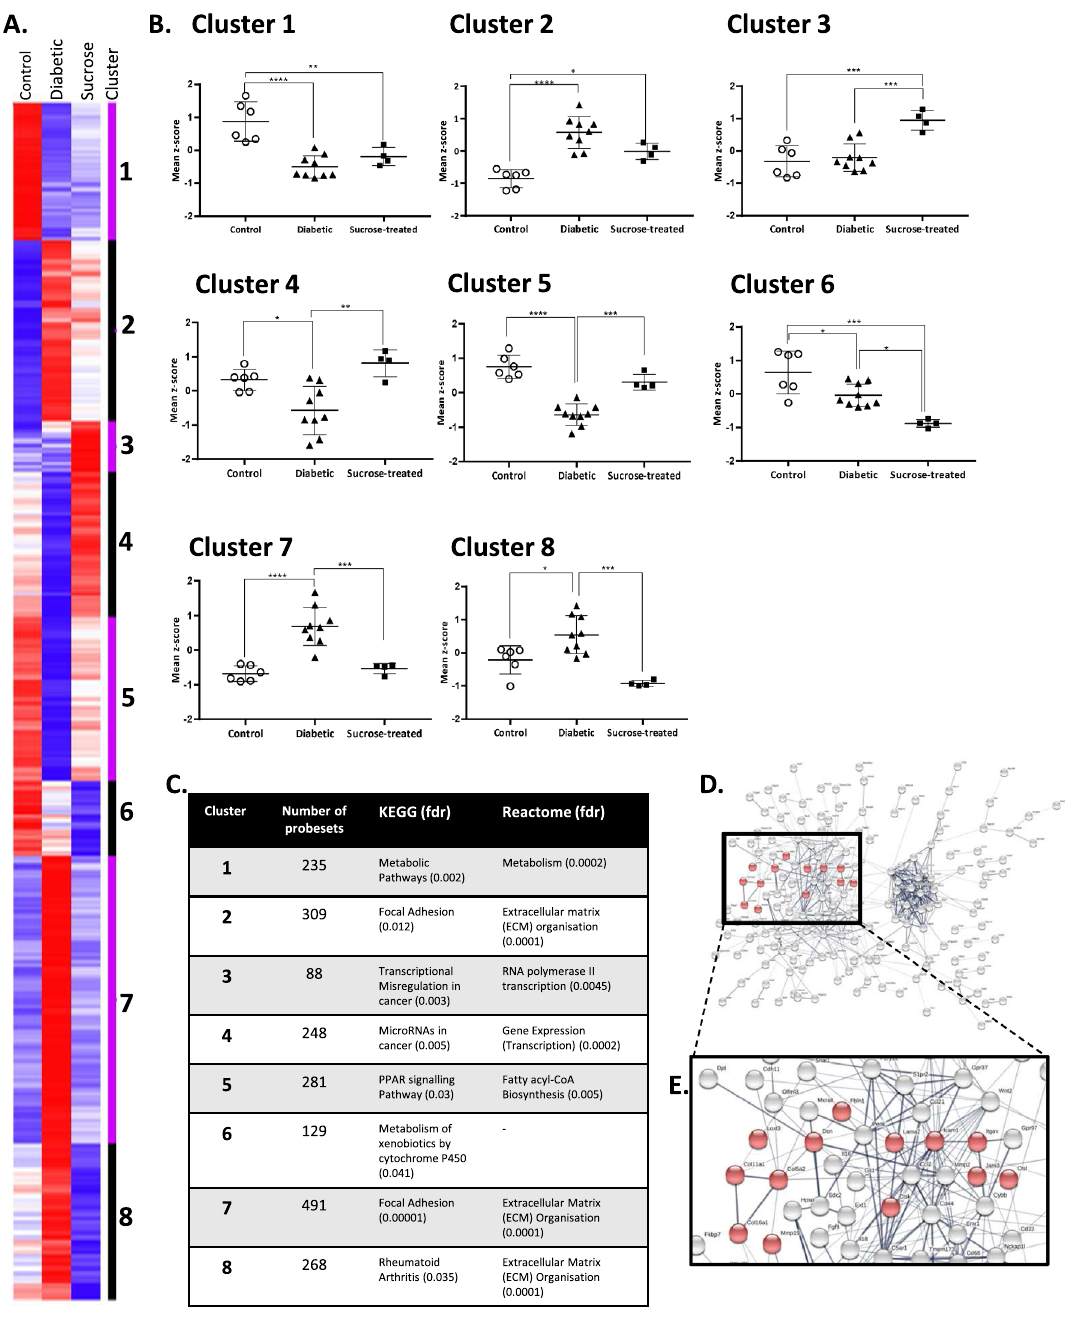
Figure 4. Cluster analysis demonstrates an altered pattern of transcript expression in the bladders of diabetic and sucrose-treated rats. κ-means clustering grouped transcripts into eight clusters ( A ) Rows are the mean transcript expression levels (Control n = 6; Diabetic n = 9; Sucrose-treated n = 4) denoted as the z ‐ score displayed in colourised (High (Red) to Low (Blue) expression) scale. Columns are experimental groups. See Supp. Fig. 7 for full cluster analysis including transcript names. ( B ) Analysis of the z-score profiles in each cluster. Data are expressed as the mean Cluster z-scores for individual animals in each group (mean ± standard deviation; one- way ANOVA followed by Tukey’s post-hoc test; * p < 0.05; ** p < 0.01; *** p < 0.001; **** p < 0.0001). ( C ) The most significant over ‐ represented KEGG pathway and reactome are shown for each cluster (see Suppl. Fig. 8 for larger image. ( D , E ) STRING network analysis of Cluster 8 highlights interaction networks and the molecules for the most significant reactome pathway (‘ extracellular matrix organisation ’) are highlighted as red coloured and annotated